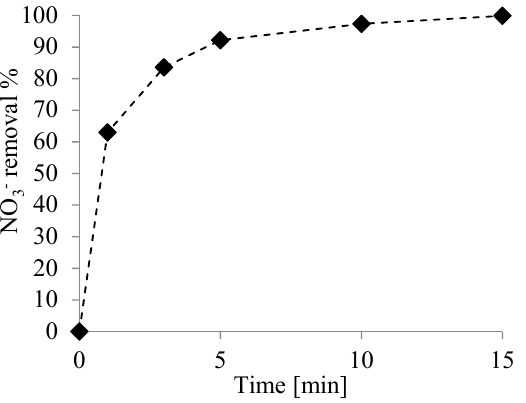
Figure 4. Nitrate removal. Condition: free pH, T = 298 K, 0.2 g L − 1 bimetallic nanoparticles, and [NO 3 − ] = 300 mg L − 1 .